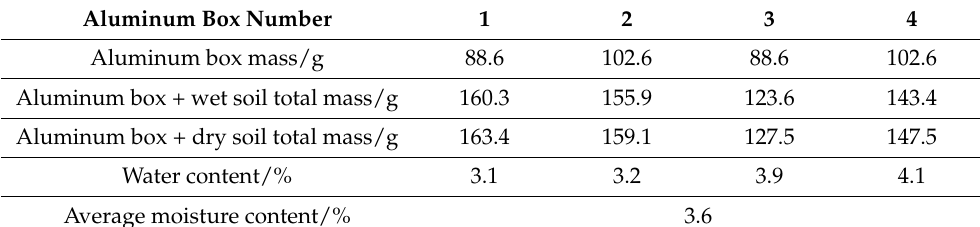
Table 1. Natural water content